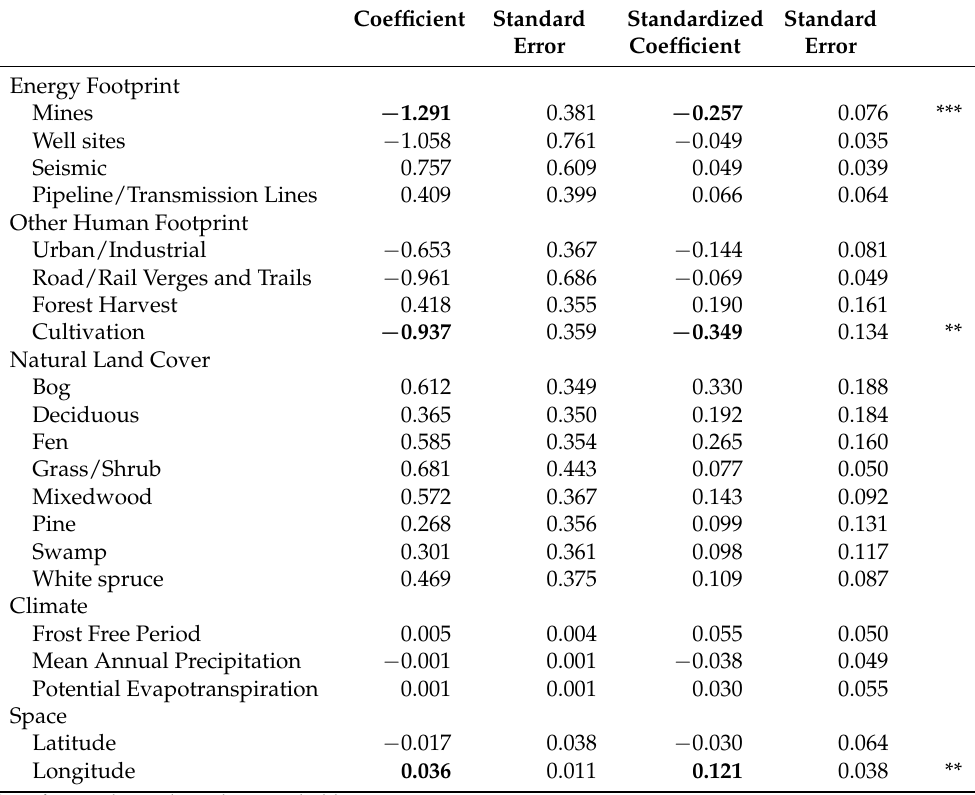
Table A3. Summaries of multiple regression model of species richness for oribatid mites in the oil sands region of Alberta, Canada.